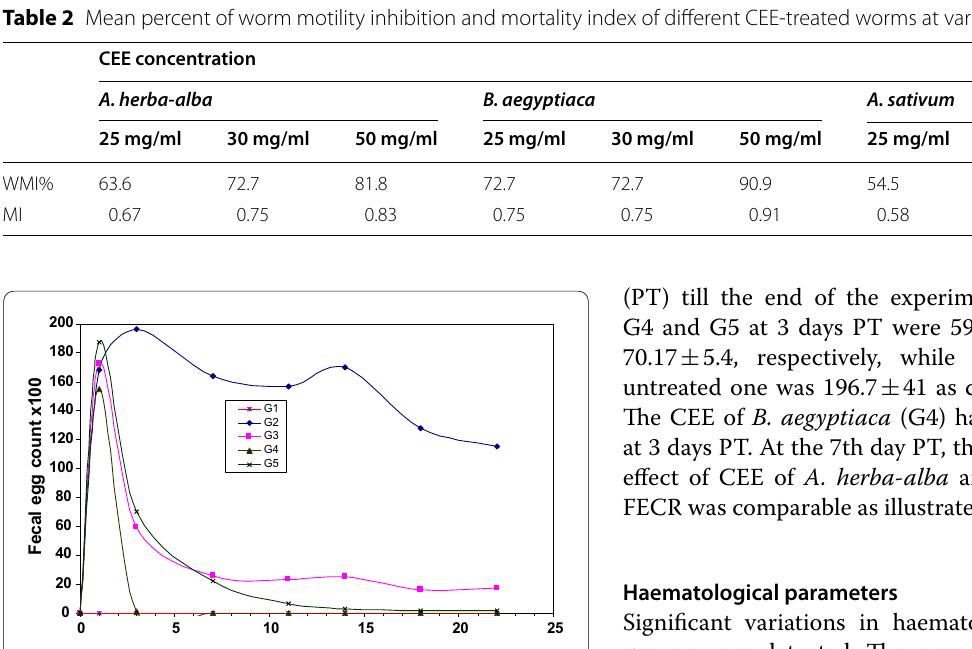
Fig. 1 Mean faecal egg counts for different sheep groups under experiment; infected untreated (G1), A. herba-alba (G2), B. aegyptiaca (G3) compared to albendazole one (G4)